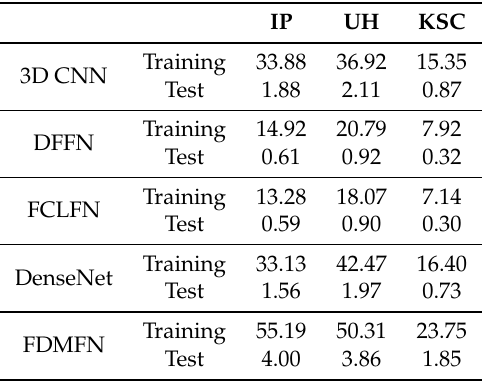
Table 10. Training and test times (in seconds) on the three datasets using different deep neural networks.